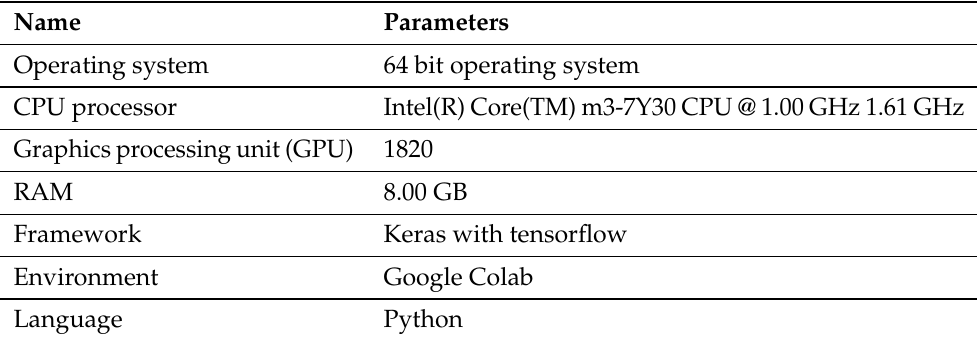
Table 2. Hardware and software